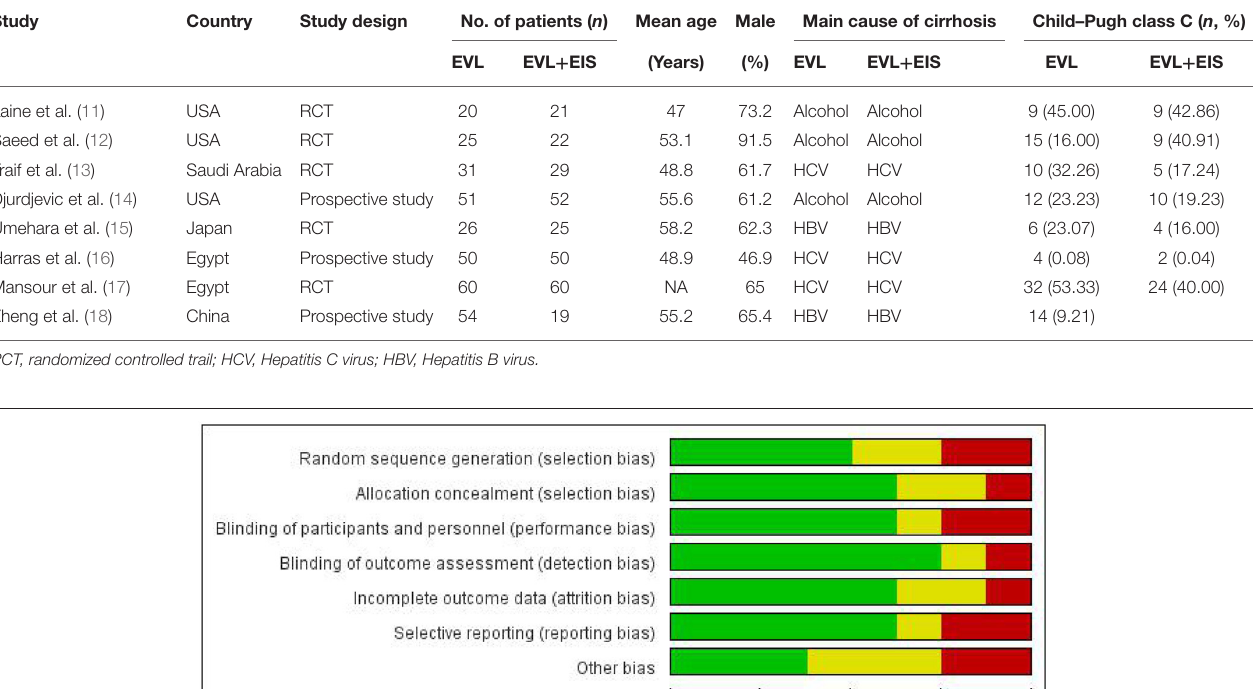
TABLE 1 | The characteristics of included studies.